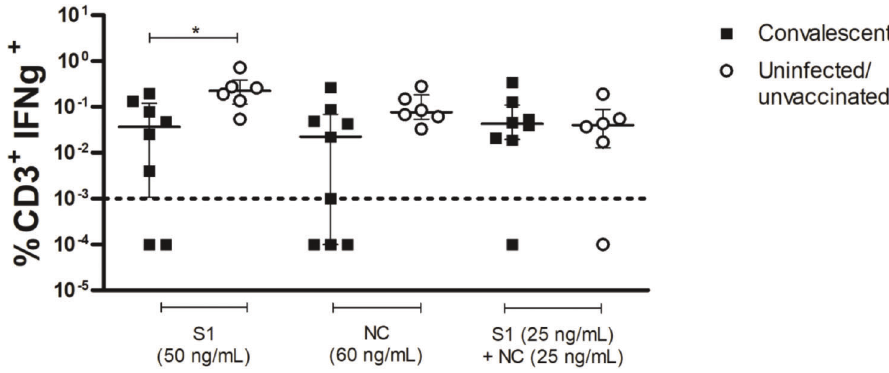
Figure 1 - T cell responses to SARS-CoV-2 proteins. PBMCs from convalescent COVID-19 individuals (black squares) (n=9) and from uninfected/unvaccinated donors (white circles) (n=6) were stimulated for five days with 50 ng/mL SARS-CoV-2 spike (S1); 60 ng/mL nucleocapsid (NC); or a mixture of both SARS-CoV-2 proteins (25 ng/mL each). The logarithmic scale represents the percentage of Tcells producing IFN- g . Scatterplots show lines at the median with interquartile ranges. The dashed line represents the assay cut-off value of 0.001%. IFN- g expression by CD3 + T cells was analyzed by intracellular flow cytometry. T-tests and nonparametric Mann-Whitney tests were used to calculate p values. Asterisks denote statistically significant differences between the groups (* p o 0.05).